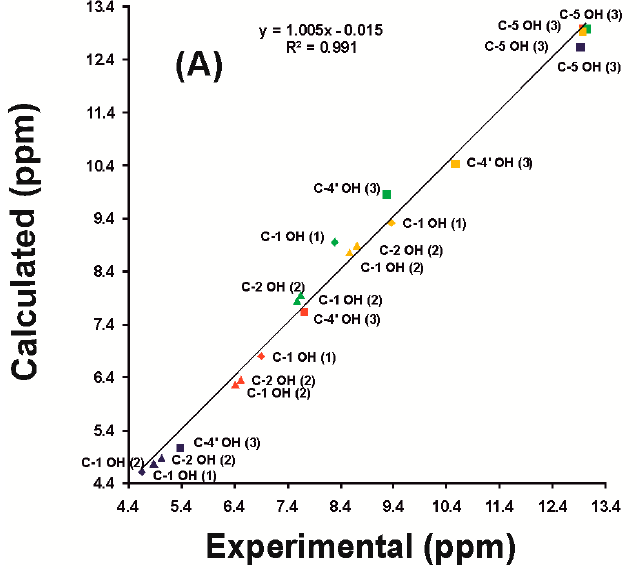
Figure 17. Calculated (at the GIAO DFT/B3LYP/6-311++G(2d,p) level of theory) vs. experimental values of the chemical shifts of the –OH protons of phenol, 4-methylcatehol and genkwanin in different solvents with minimization of the solvation complexes at the DFT/B3LYP/6-31+G(d) ( A ) and DFT/B3LYP/6-311++G(d,p) ( B ) level of theory. Reprinted with permission from [41]. Copyright 2013, The Royal Society of